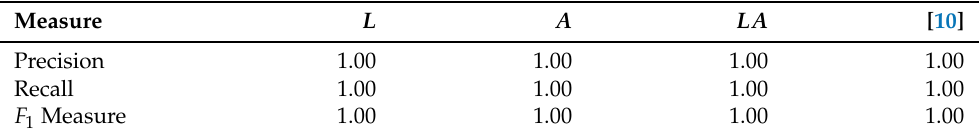
Table 4. Experimental results for the accuracy of the main plot